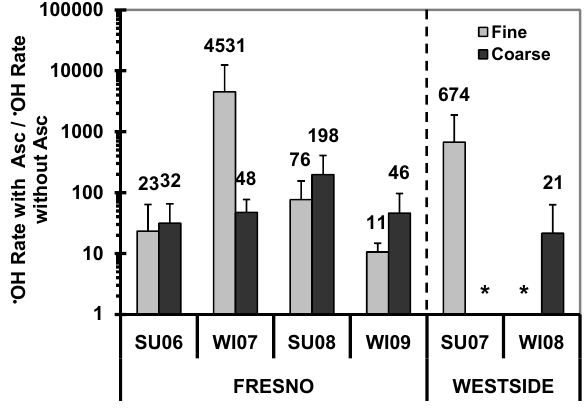
Fig. 6. Ratios of the initial rate of • OH formation in SLF with ascorbate over the initial rate of • OH formation in SLF without ascorbate. An asterisk “*” indicates that there is no • OH generation within the first 1h of extraction in SLF without Asc. Since the ini- tial rate of • OH formation without ascorbate in all samples except the Fresno winter 2009 fine PM was not statistically different from zero (Fig. 5), we are likely underestimating the effect of ascorbate in amplifying • OH generation for most of the PM samples.